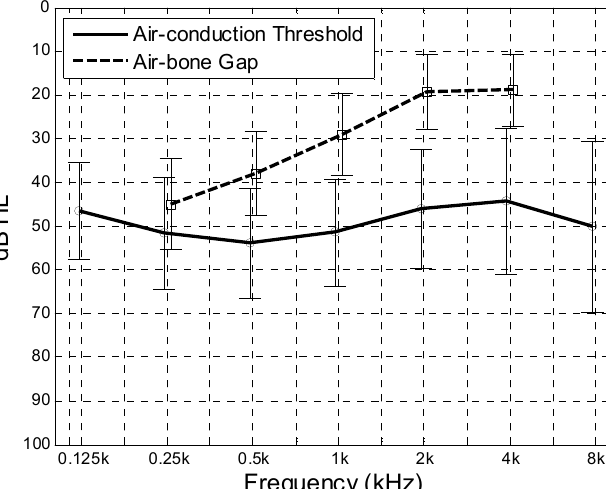
Figure 3. Preoperative air-conduction hearing threshold and air-bone gap in the Otosclerotic group. Mean value (thick lines) and standard deviation (whiskers).